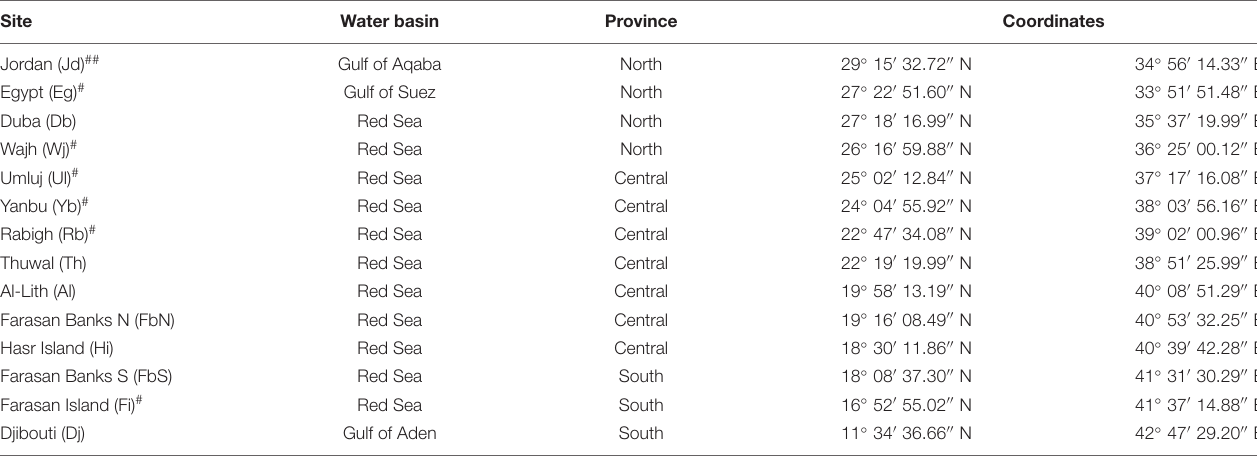
TABLE 1 | Sampling sites in the Saudi Arabian Red Sea and Djibouti with provinces and